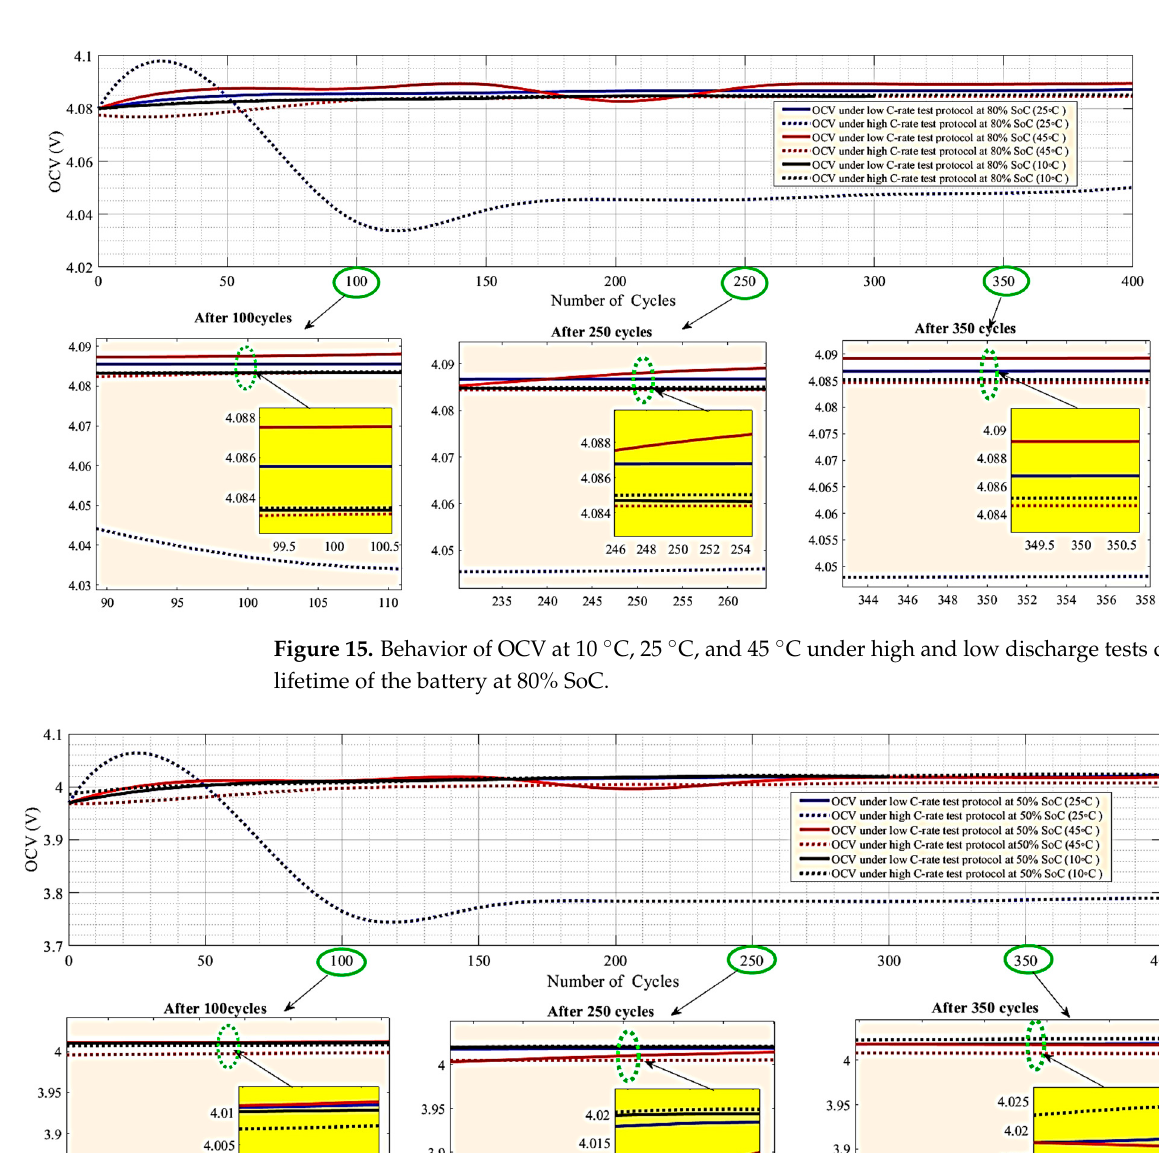
12 of 17 Figure 14. OCV distribution at different SoC percentages at 25 °C under different test conditions. Under different discharge current test protocols, the OCV distribution results showed that the OCV drops when the C-rate was ≥ 2C during the lifetime of the battery.